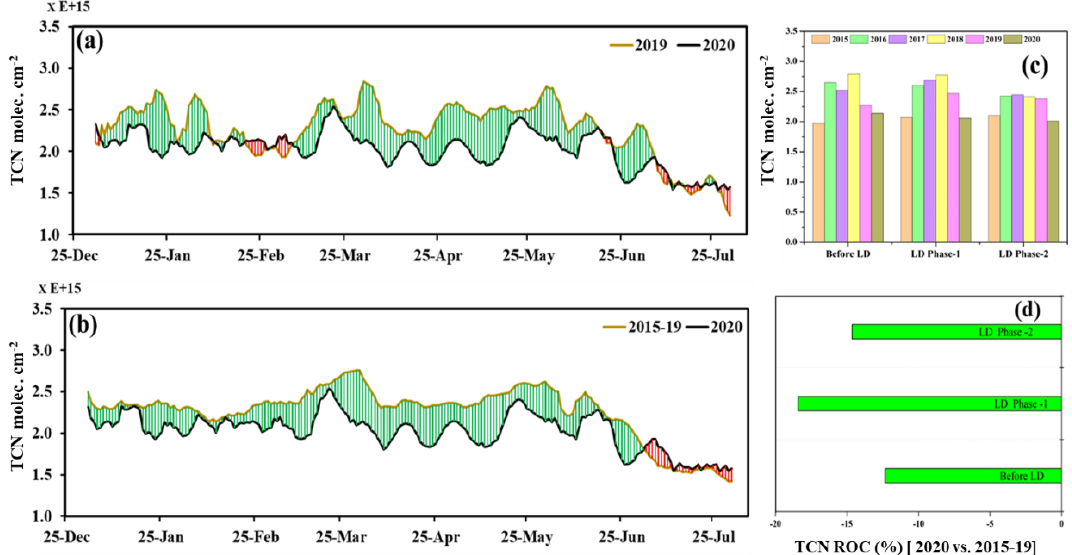
Figure 3. Moving-average time series analysis during January–July of TCN during (a) 2019 vs. 2020, (b) short-term climatological mean of TCN (2015–2019) vs. 2020, (c) annual variations in TCN (2015–2020) during the period before lockdown and different phases of lockdown, and (d) rate of change of TCN during 2020 vs. the 2015–2019